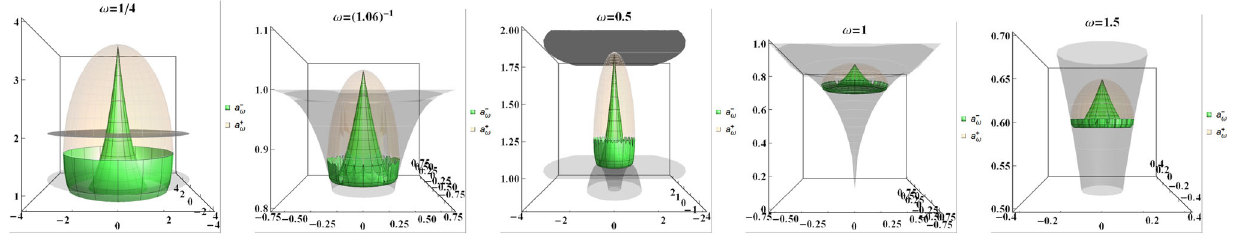
Fig. 9 Kerrgeometries:surfaces a ± ω (inunitsofmass)versustheradius r / M for different frequencies ω , including BH and NS geometries – see also Eq. (15). 3 D representations of a ± ω versus r / M for different frequencies – see also Fig. 8. Each surface is a metric bundle g ω for a fixed value of ω 0 = constant. The corresponding metric bundle origin is a 0 = M /ω 0 . The surfaces a ± ω are represented as revolution surfaces with height a ± ω ( vertical axes ) and radius r / M (horizontal plane). Sur- faces are generated by rotating the two-dimensional curves a ± ω around an axis (revolution of the function curves a ± ω around the “z” axis). Thus,